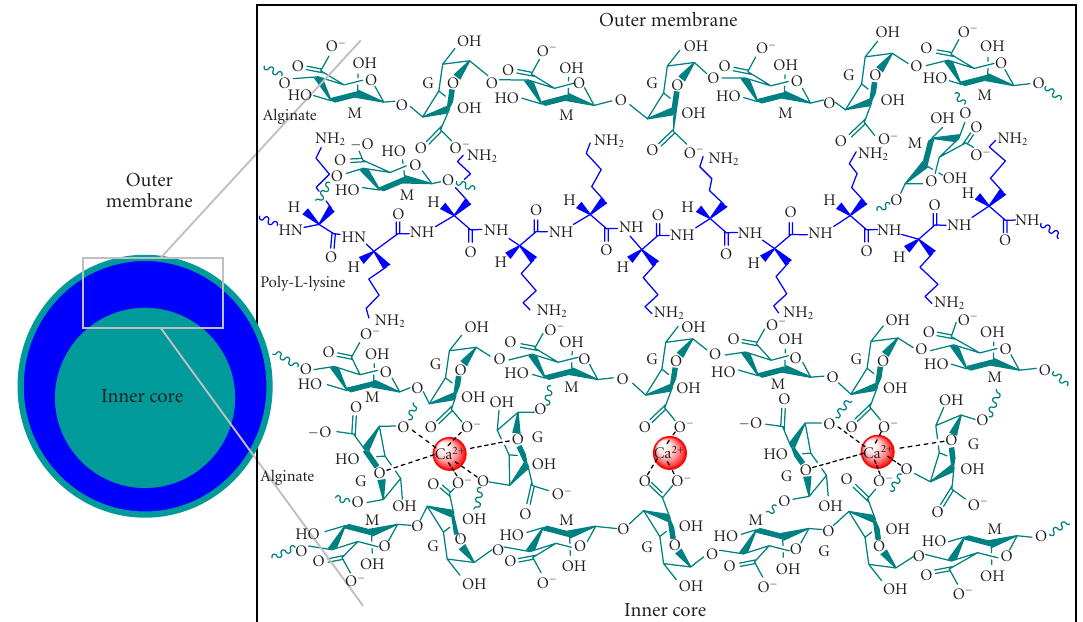
Figure 4. Electrostatic interactions of polymer layers in alginate-poly-L-lysine-alginate artificial cell